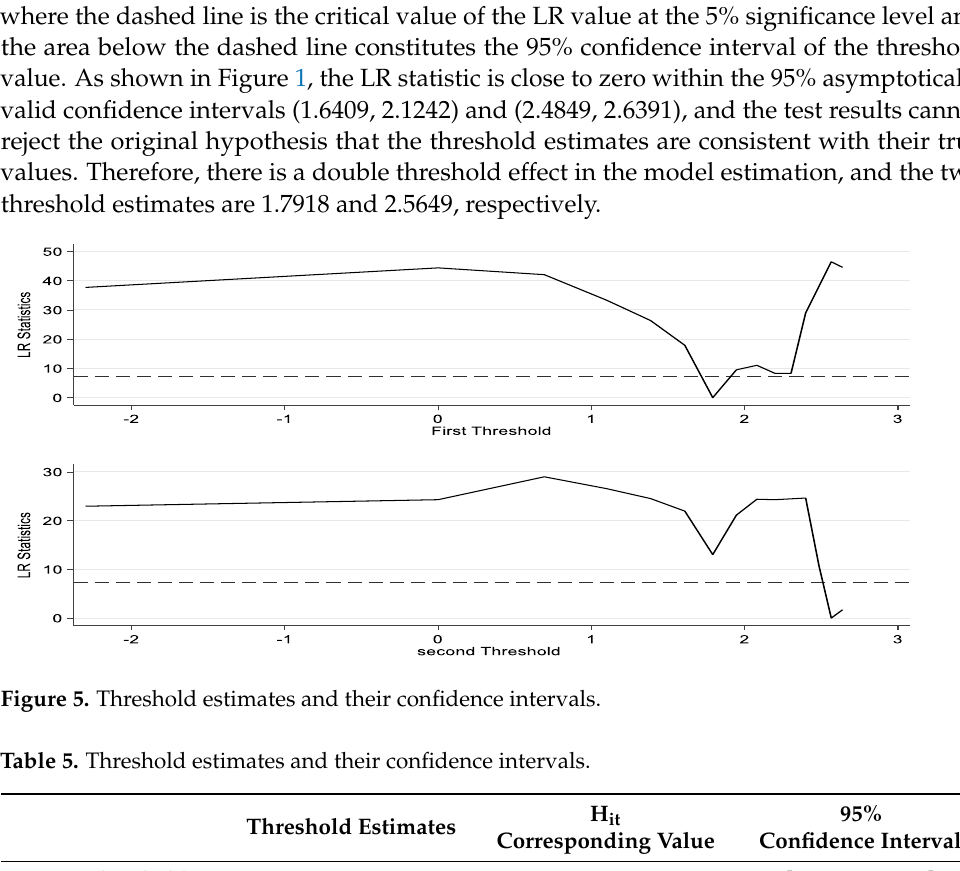
Table 5. Threshold estimates and their confidence intervals.